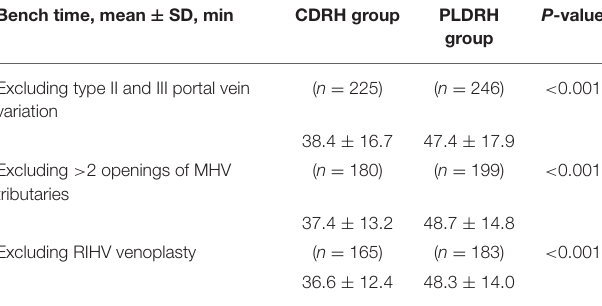
TABLE 3 | Subgroup analysis based on variations in vascular of liver